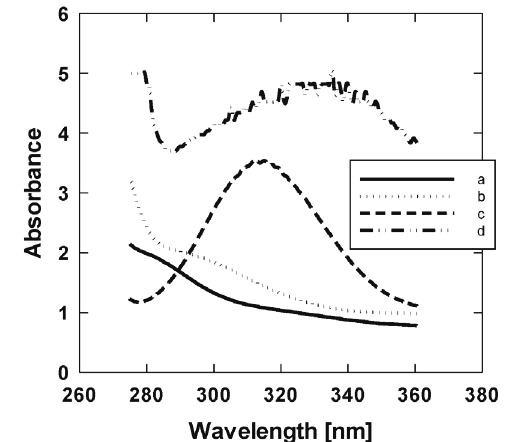
dissolved in HCl 0.1 mol dm –3 3 dis- 3